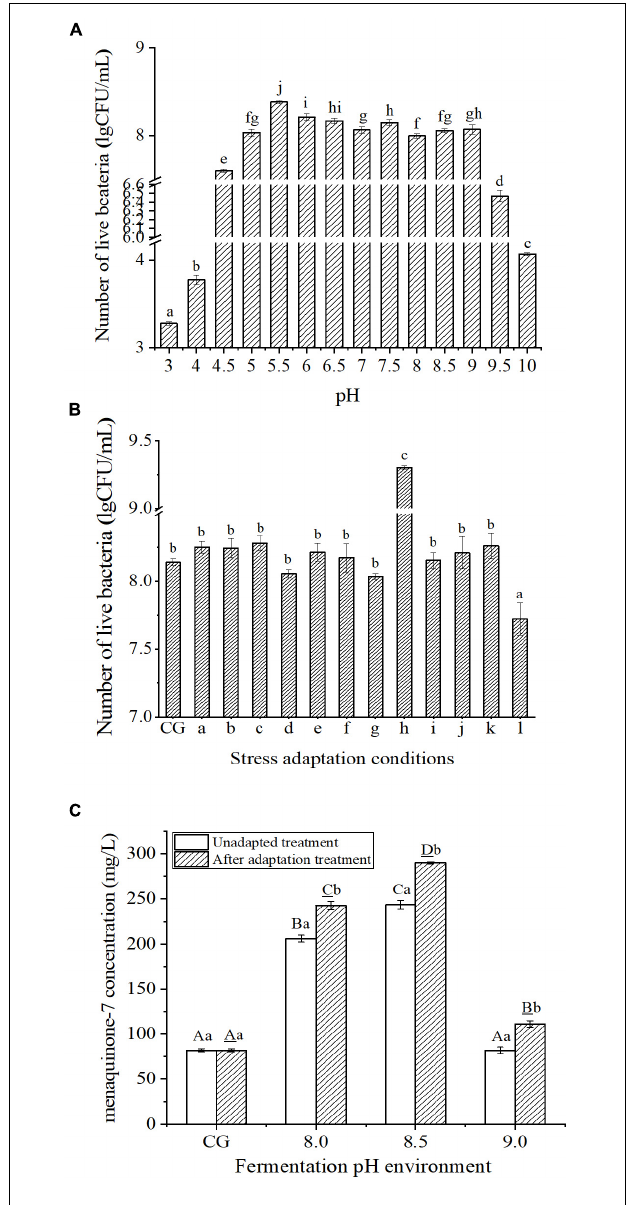
FIGURE 1 | (A) Growth of Bacillus subtilis natto CICC10262 at different pH. Different lowercase letters indicated that the values of each group were significantly different, P < 0.05. (B) Effects of different stress adaptation conditions on the growth of Bacillus subtilis natto CICC 10262. In group a, b, and c indicated that the strain was adapted to (nutrient agar) NA medium containing 1% (w/v), 3% (w/v), and 5% (w/v) NaCl for 0.5 h, d, e, f, g, h, i were strains adapted to NA medium at pH 4.5, 5.0, 6.0, 8.0, 8.5, 9.0 for 0.5 h, j, k, l were strains incubated at 42 ◦ C, 45 ◦ C, 48 ◦ C for 0.5 h, then inoculated into NA medium containing 3% (w/v) NaCl with normal pH and cultured at 37 ◦ C for 24 h. In the significance analysis, different lowercase letters indicated that the values of each group were significantly different, P < 0.05. (C) The yield of MK-7 fermented by strain under different pH conditions. Different lowercase letters indicated that there were significant differences between different stress intensities in the unadapted treatment group, P < 0.05. Different capital letters indicate that under the same pH condition, the difference between the unadapted treatment group and the adaptation treatment group is statistically significant, P <